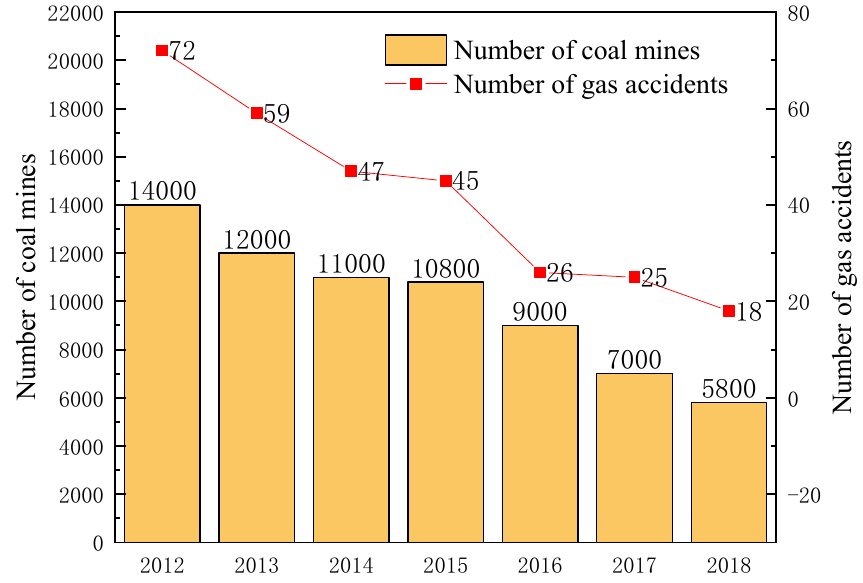
Figure 13. Changes in the number of gas accidents and coal mines.